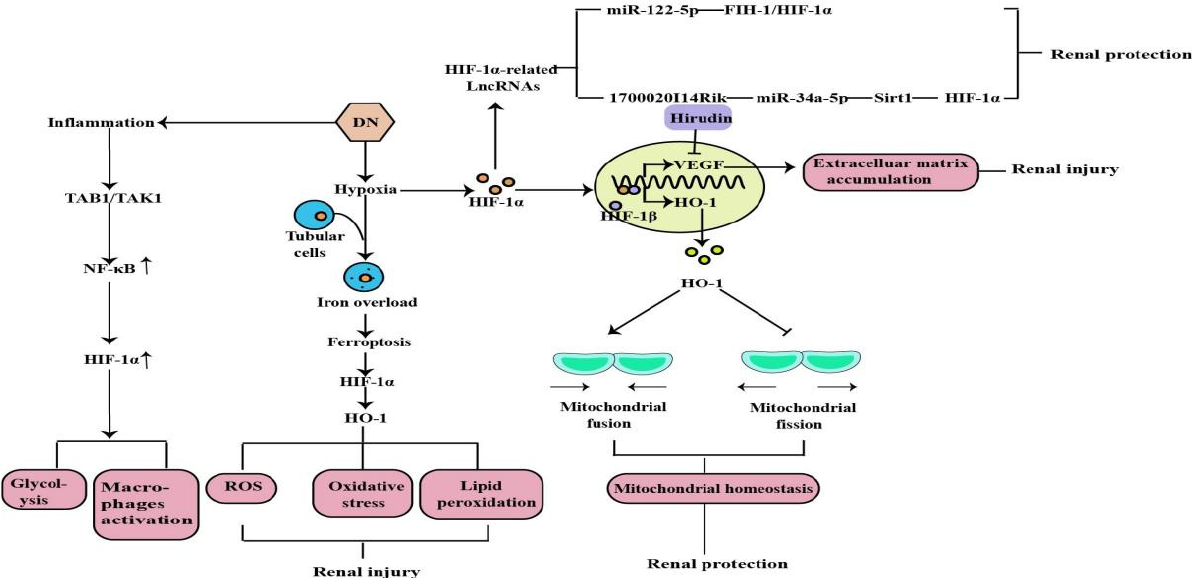
Figure 3. Mitochondrial dysfunction, lipid peroxidation, oxidative stress, ROS, machrophages activation, glycolysis, and the induction of inflammation are the major factors in the pathogenesis of DN, and HIF-1 α can protect and aggravate the kidney injury caused by DN through the above mechanisms( ↑ : elevated expression).